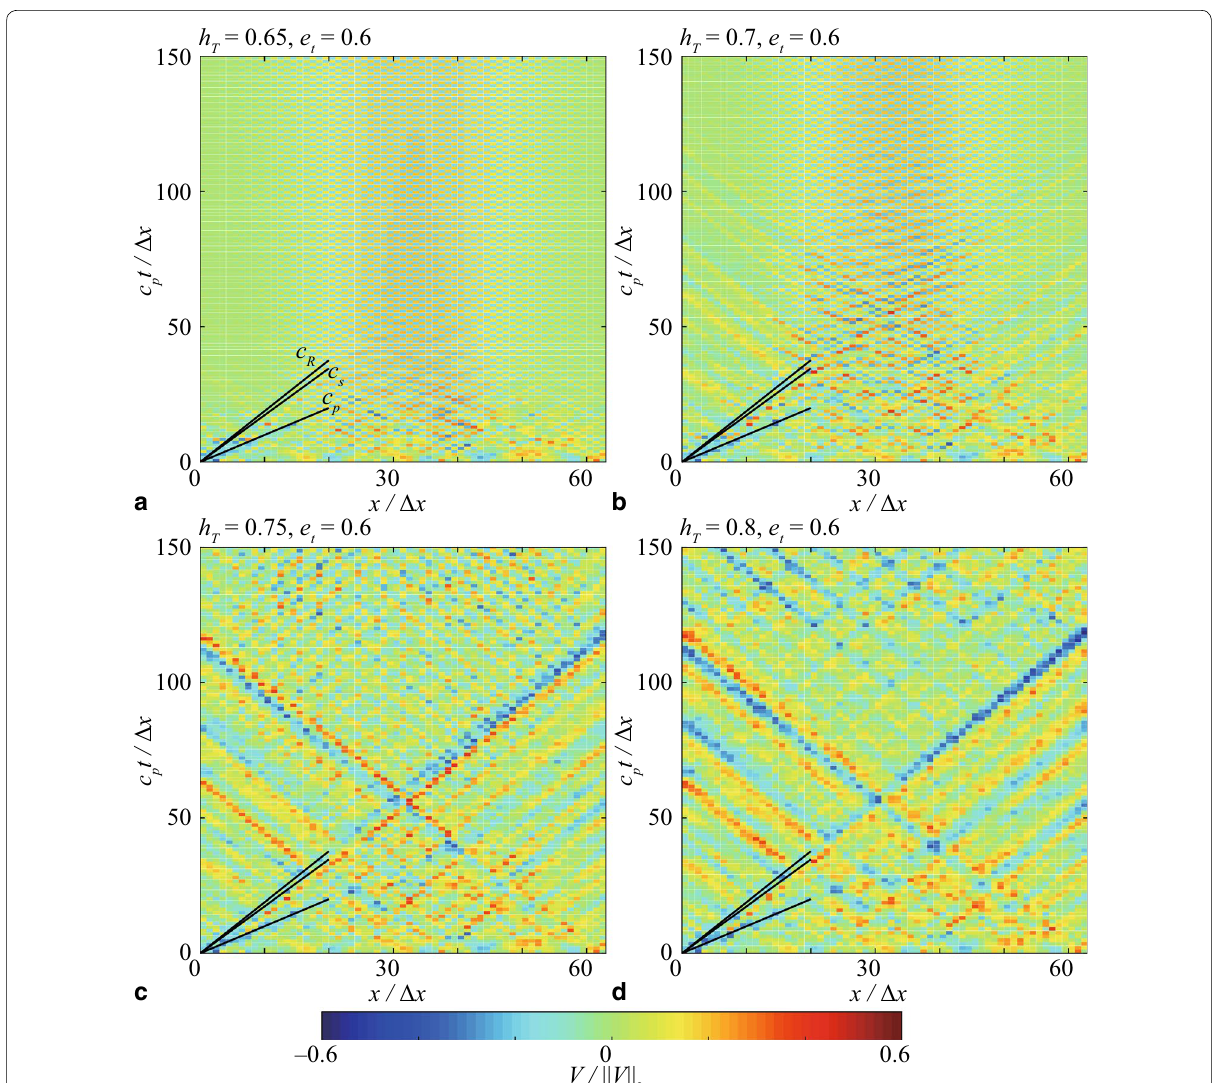
Fig. 4 Spatiotemporal distribution of V normalized by its L 2 norm (Eq. 17) defined for each snapshot in the simulations for numerical stability analysis plotted in Fig. 3 under Mode II loading conditions with h T of a 0.65 , b 0.7 , c 0.75 , and d 0.8, and e t = 0.6 . Three black lines from the origin represent the wave